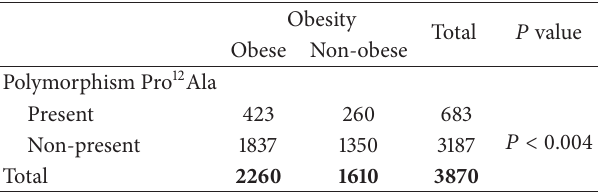
Table 5: Pro 12 Ala polymorphism and obesity.